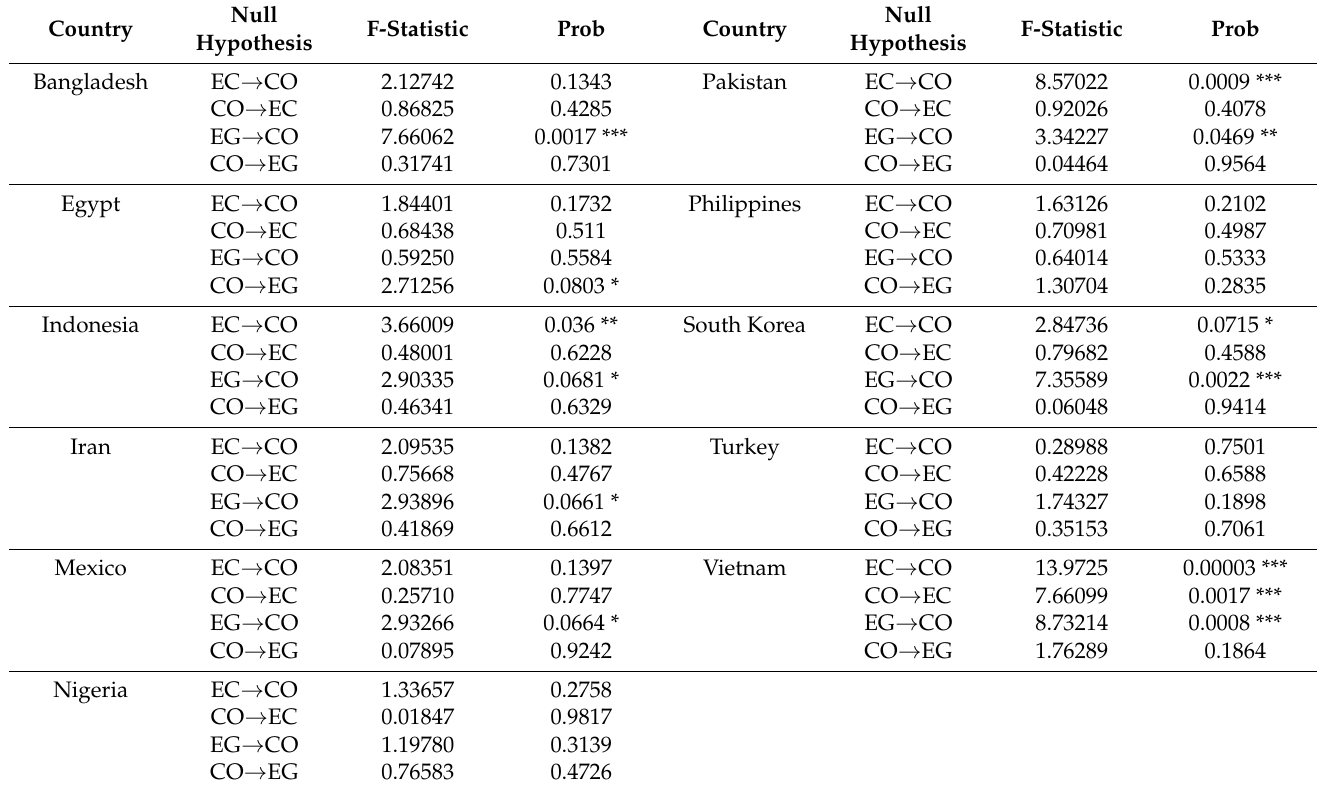
Table 5. Linear Granger causality